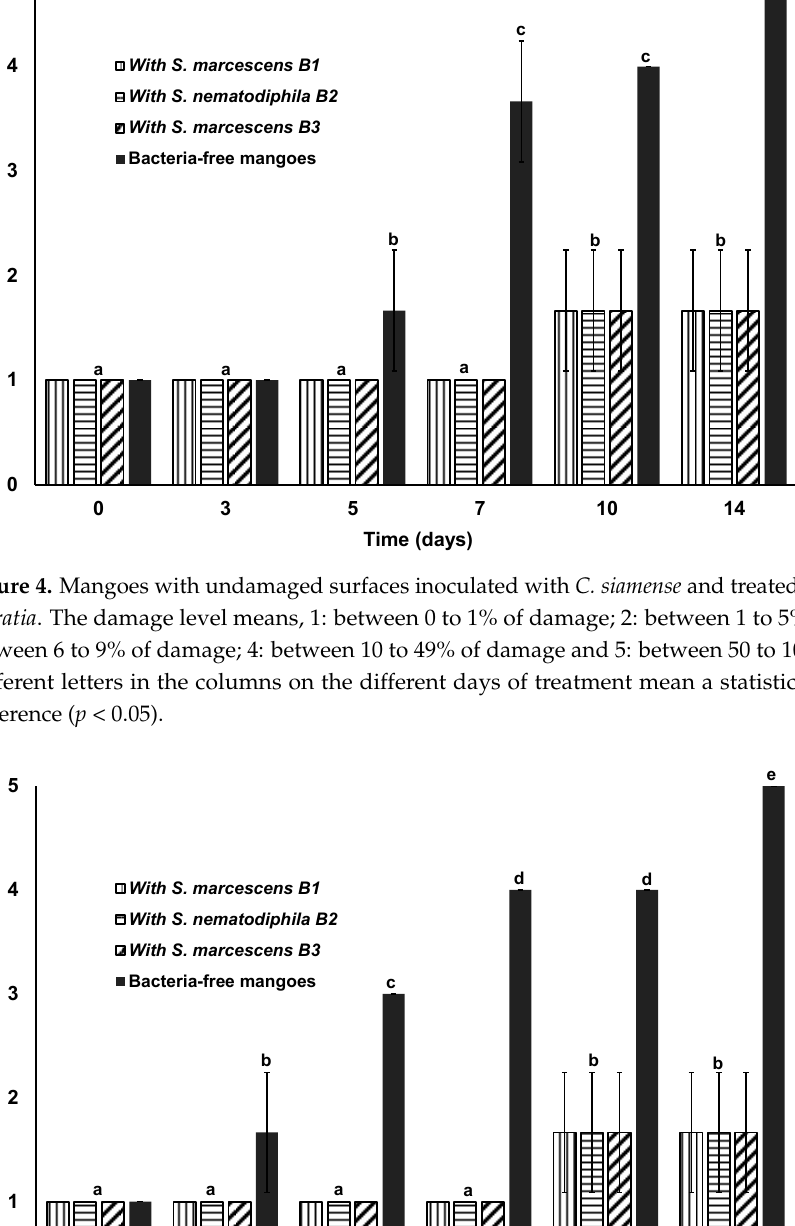
Figure 3. Mangoes with lesions inoculated with C. siamense and treated with strains of Serratia . The damage level means, 1: between 0 to 1% of damage; 2: between 1 to 5% of damage; 3: between 6 to 9% of damage; 4: between 10 to 49% of damage and 5: between 50 to 100% of damage. Different letters in the columns on the different days of treatment mean a statistically significant difference ( p < 0.05).